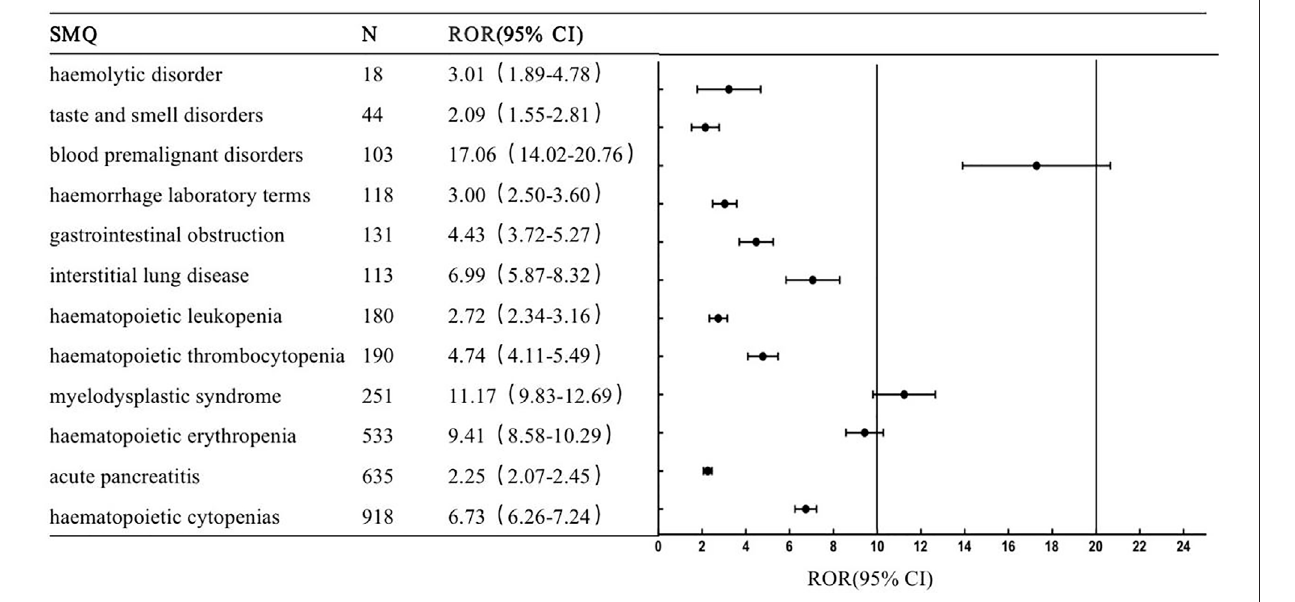
FIGURE 1 | The positive signal distribution of Olaparib using standardized MedDRA queries.